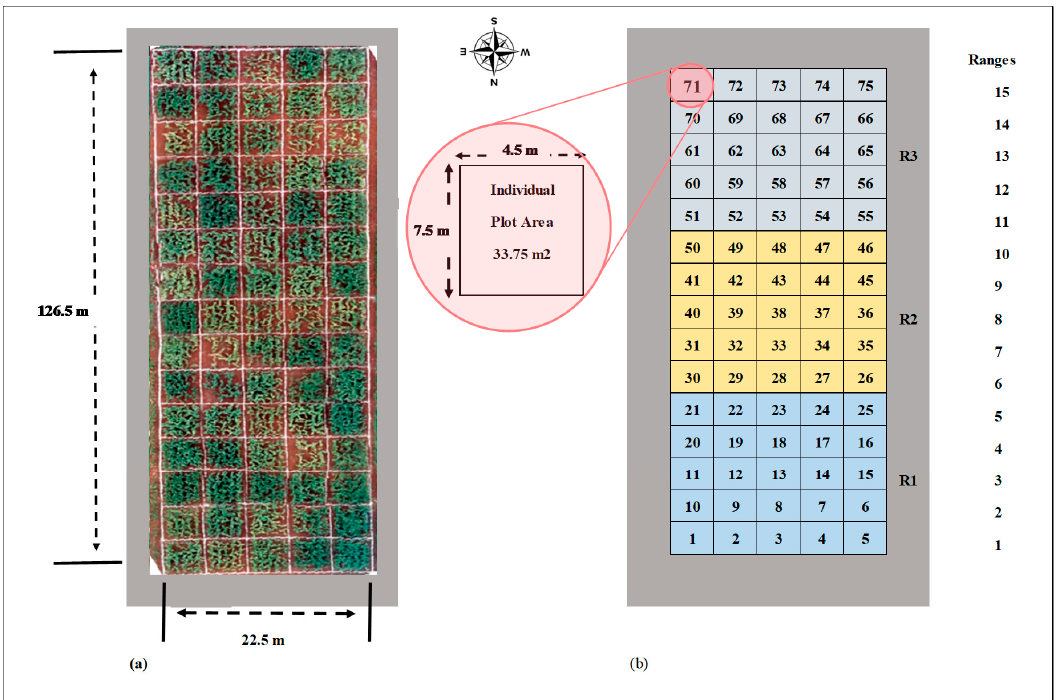
Figure 3. Field layout showing ( a ) the experimental area (aerial image to the left with plots demarcated using agricultural lime—white lines) taken using the unmanned aerial vehicle (UAV) RGB camera and ( b ) the experimental layout (right) of 25 varieties × 3 replications (R1–3) in different colors. The insert shows individual plot dimensions.